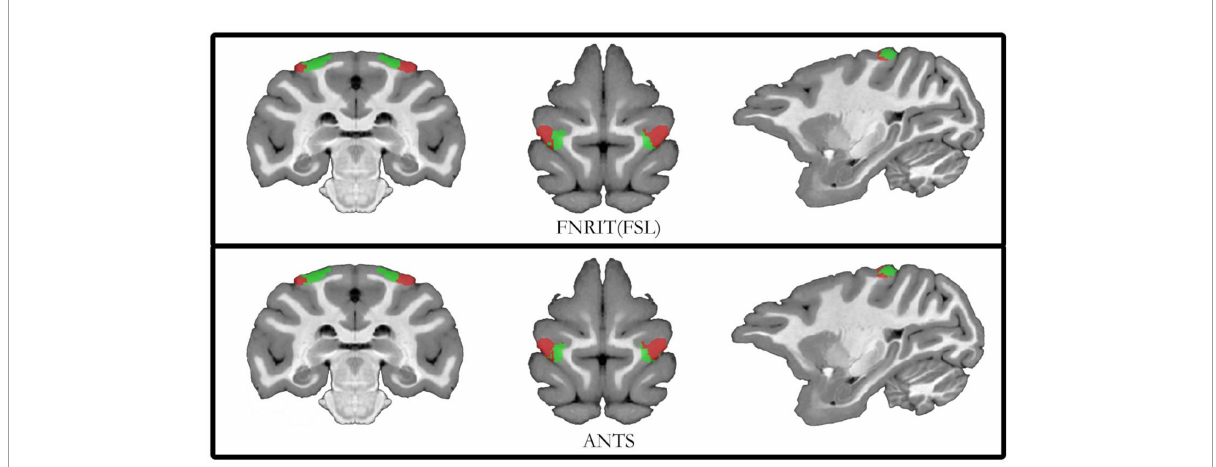
FIGURE5 Diagram of subdivision results based on FNIRT and ANTs registration. The top of the schematic shows the results of registration using the FNIRT method. Below the schematic diagram is the result of the registration of the partitions using the ANTs tool.